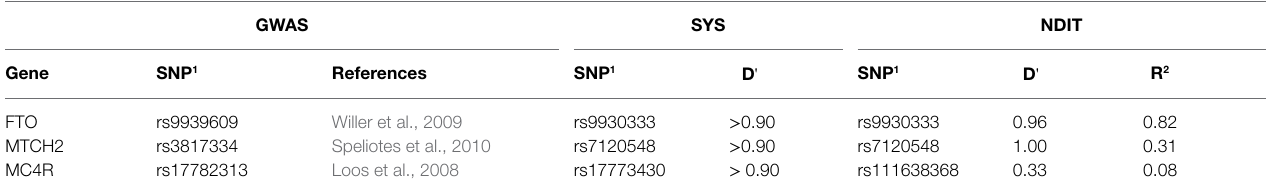
TABLE 1 | Measure of linkage disequilibrium (LD; D ' ) between single nucleotide polymorphisms (SNPs) previously reported in genome-wide association study (GWAS), Melka et al. (2012) and Nicotine Dependence In Teens (NDIT)